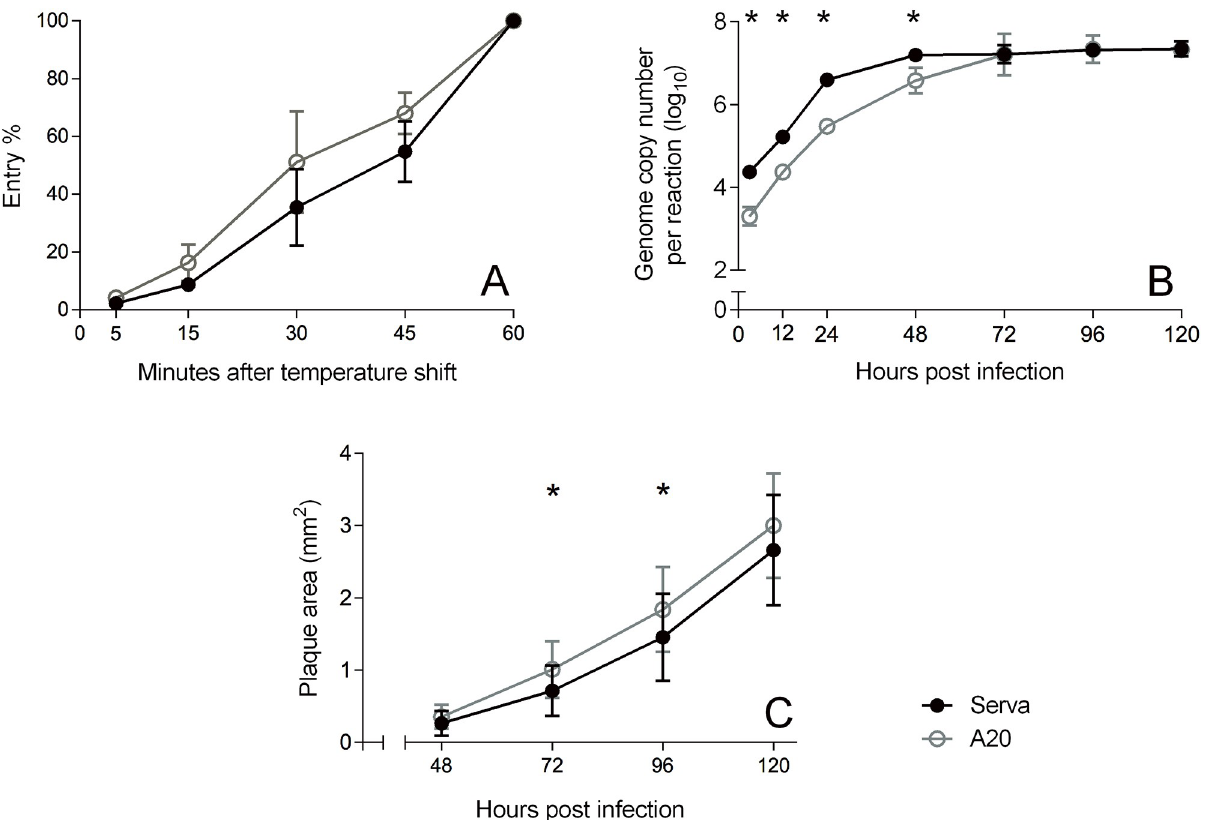
Fig 1. Growth kinetics of Serva (closed circles) and A20 (open circles) strains of ILTV in CEK cells. (a) Entry kinetics of Serva and A20 in CEK cells. The mean and standard deviation from 3 independent experiments are shown. No significant difference between the two different viruses was detected at any time point (b) Multi-step growth curve of Serva and A20 in CEK cells infected with a MOI of 0.001. The mean and standard deviation of triplicate measurements performed in each of 3 independent experiments are shown; � indicates p < 0.05 (Student’s t -test). (c) Kinetics of plaque development by the Serva and A20 strains of ILTV in CEK cells. The mean and standard deviation of the plaque area (mm 2 ) of 13 to 22 individual plaques at each time point are shown; � indicates p < 0.05 (Student’s t -test).